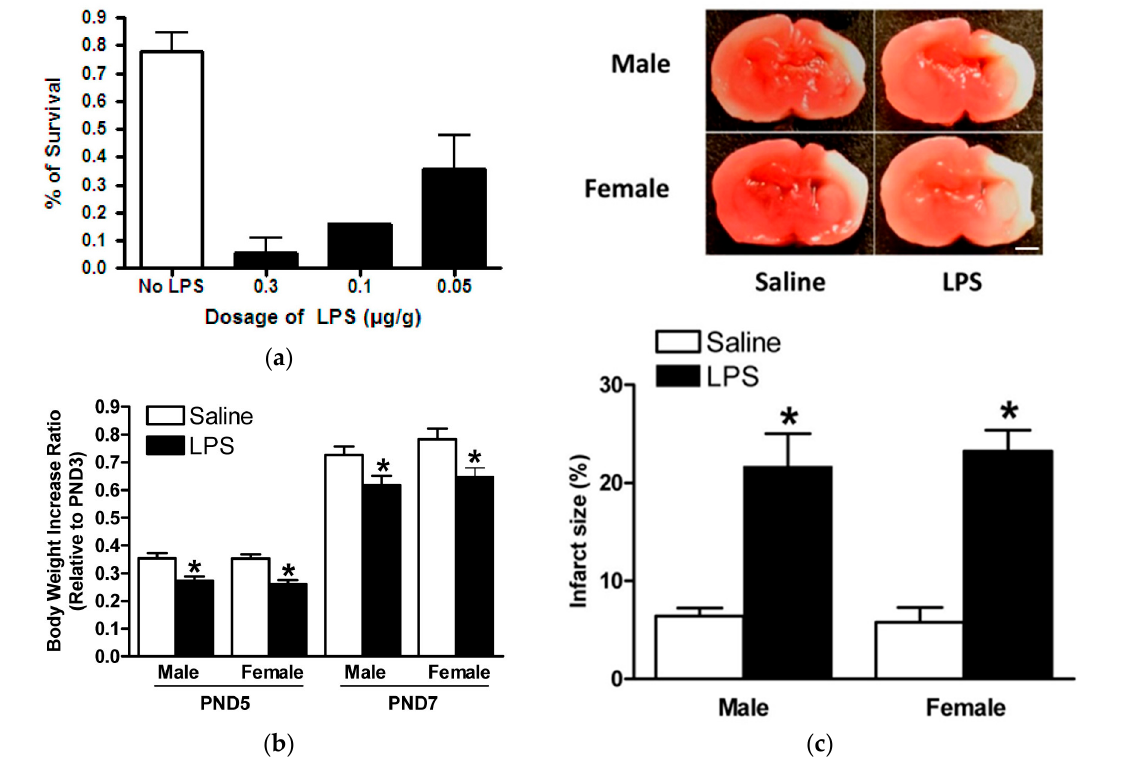
Figure 4. LPS sensitizes neonatal rat brain to HIE. LPS intraperitoneal (i.p.) injection prior to HIE insult on postnatal day 7 (PND7). ( a ) Different doses of LPS via i.p. injection administered 4 h before HIE significantly increased mortality rate in rat pups, compared with the saline control; ( b ) LPS, 0.05 mg/kg, ( n = 26) via i.p. injection on PND3 and PND5 significantly hindered normal body weight increases in rat pups compared to controls ( n = 22); and ( c ) representative brain slices are shown above. Pups given LPS, 0.05 mg/kg, ( n = 23) via i.p. injection on PND3 and PND5 had significantly increased brain infarct size in both genders of neonatal rat pups after HIE insult, compared to controls ( n = 18). Data are means ± SEM, * p < 0.05. Scale bar, 2 mm.